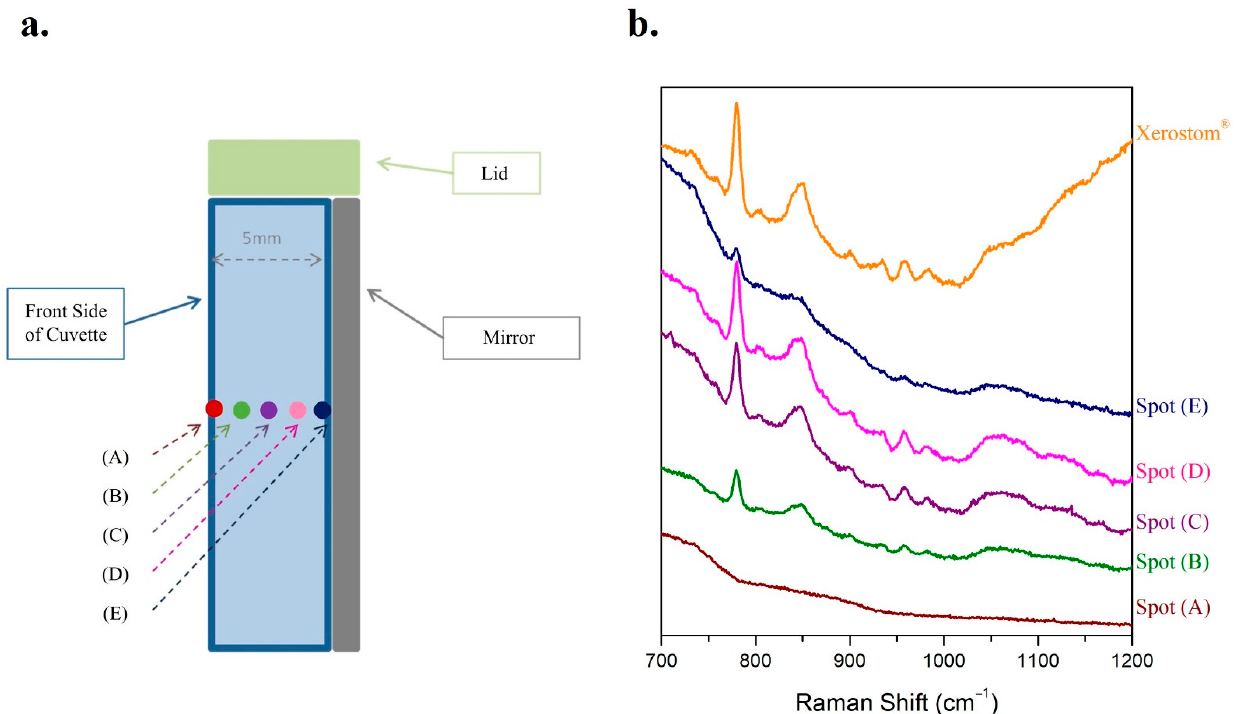
Molecules 2022 , 27 , x FOR PEER REVIEW Figure 4. The method of the commercially available cuvette was applied on a liquid sample of Xerostom ® . ( a ) Schematic illustration of the focus on five different spots of the cuvette; ( b ) the respective Raman spectra of Xerostom ® from the five different focuses on the cuvette were recorded.